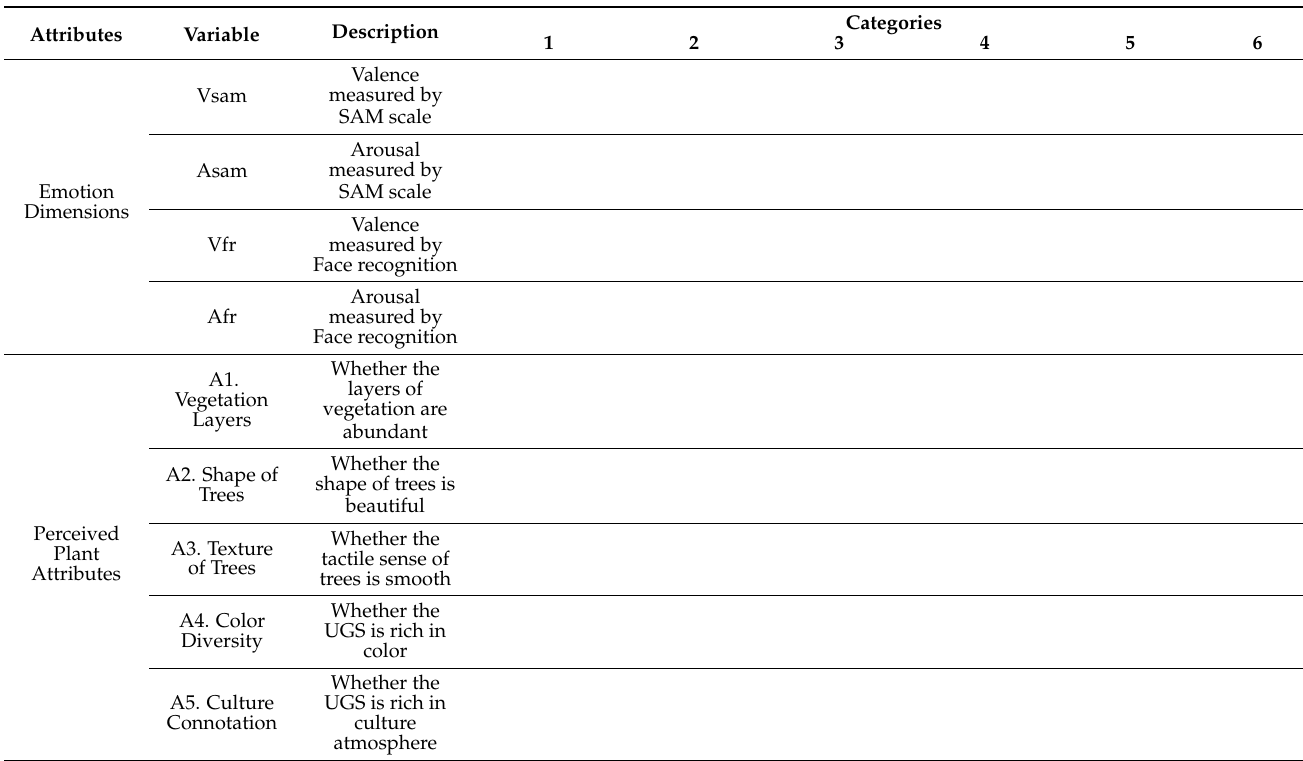
Table 1. Scale of spatial quality for sample